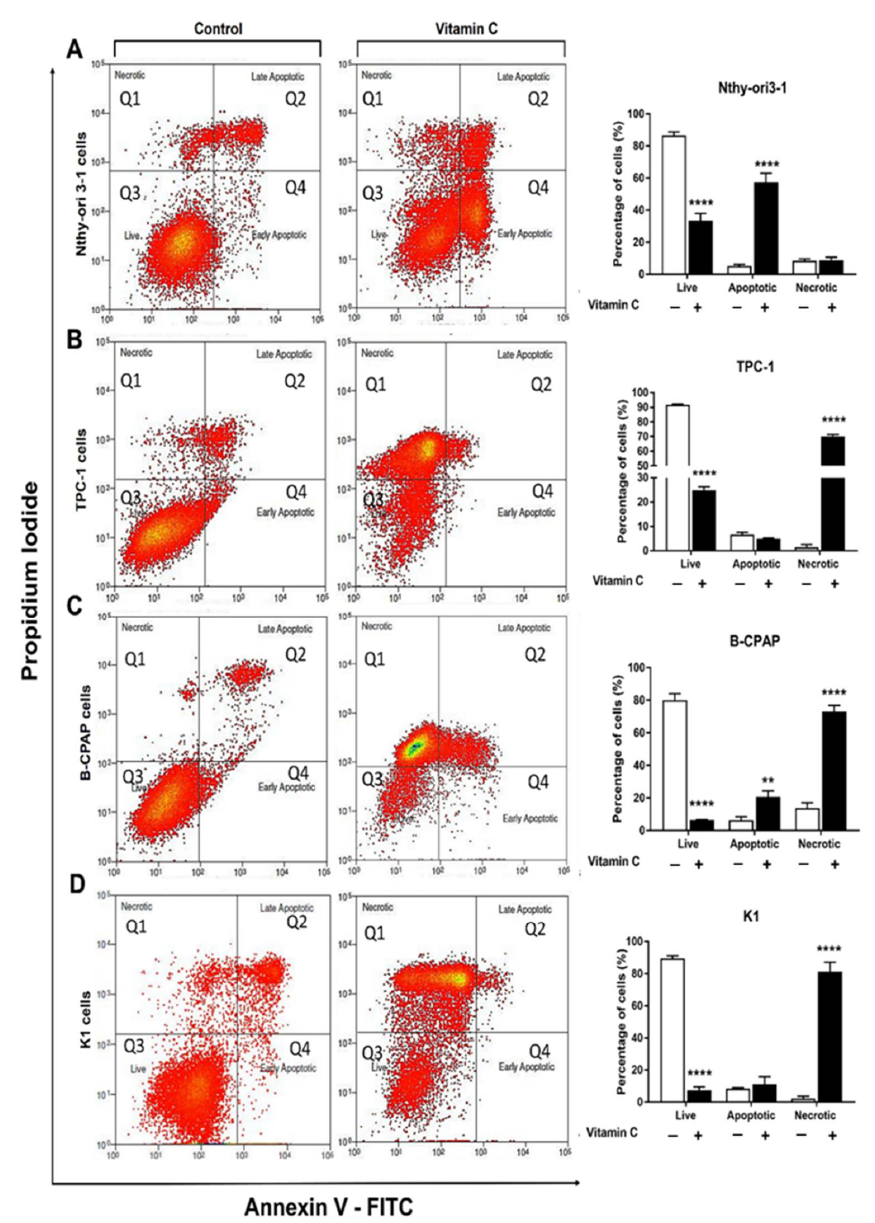
Figure 2. Percentage of live, apoptotic, and necrotic cells measured by flow cytometry using the PI-annexin V assay. Dot plots showing cell death in all cell lines treated for 48h with different doses of vitamin C: Nthy-ori 3-1 with 15 mM ( A ), TPC-1 with 10 mM ( B ), K1 and B-CPAP with 5 mM ( C and D ). Bar graphs are representative of three experiments and show the percentage of live, apoptotic (early apoptotic and late apoptotic cells), and necrotic cells. Data are expressed as the Mean of % cells ± SD. All experiments were performed three times independently, each time in triplicate, to confirm the results. Statistical analyses were performed by Student t-test. Statistical differences vs control are expressed with superscript symbols: ** p < 0.01; **** p < 0.0001. 3.2. Oxidative Stress Induced by Vitamin C in PTC-Derived Cells To confirm the pro-oxidant vitamin C effect, changes in the redox balance were as- sessed by measuring intracellular oxidants and antioxidant species in cells exposed to 5 mM vitamin C (the lowest observed cytotoxic concentration for 2 out of 3 PTC-derived